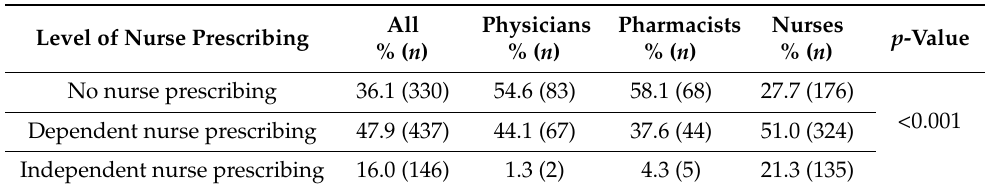
Table 3. Physicians’ pharmacists’ and nurses’ opinions about the extent to which nurses should be allowed to prescribe medicines, in order to obtain best quality of care and patient outcomes (=ideal situation, which can be different from the current situation).